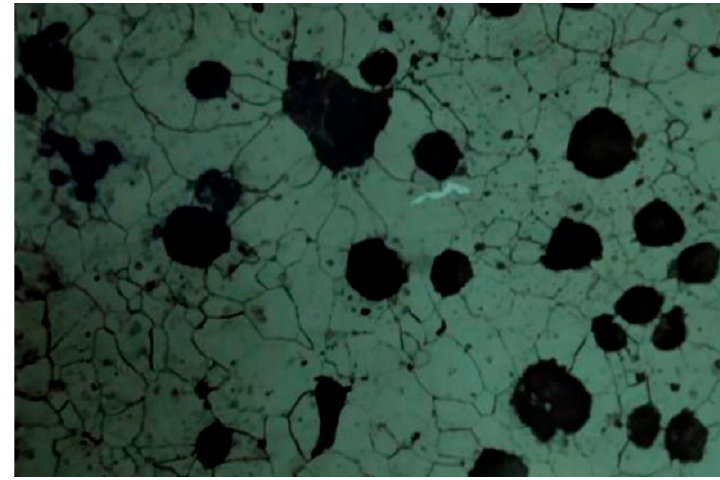
Figure 2. Ferrite microstructure (Magnification: 136×).